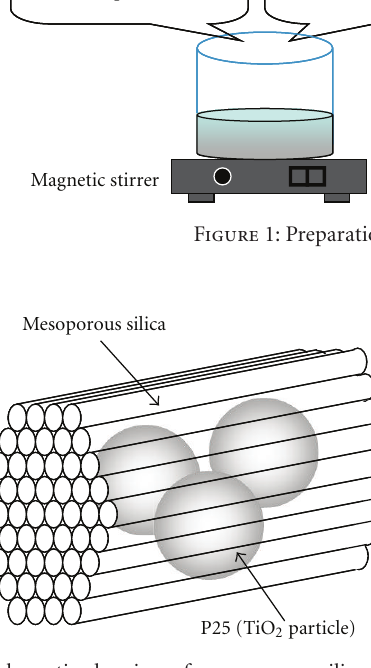
Figure 3: TEM image of mesoporous silica loaded with TiO 2 particlesfor the ratio of loaded TiO 2 of 15